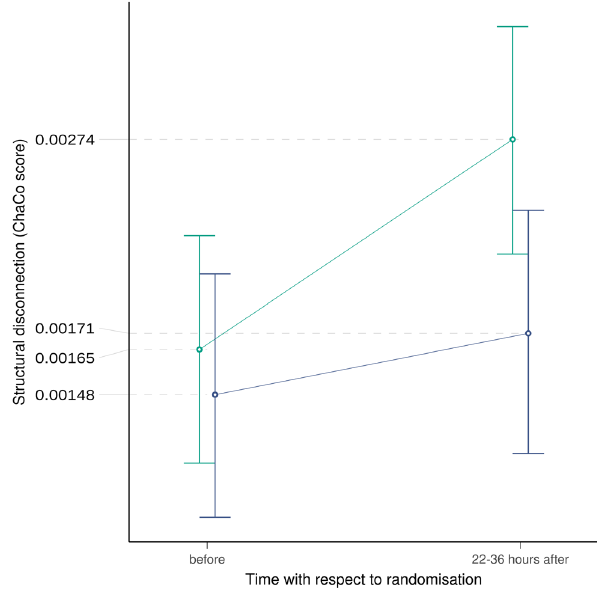
Fig. 3 Progression of average structural disconnection after stroke from before (T1) through 22 – 36h after (T2) randomization ( n = 269 biologically independent subjects examined at two time points), strati fi ed by allocation to placebo (persian green) or alteplase (tory blue). Circles represent structural disconnection quanti fi ed by mean average logarithmic Change of Connectivity (ChaCo) scores for the two groups. Vertical bars indicate 95% con fi dence intervals. The increase in structural disconnection, i.e. progressive loss of connectivity, is statistically signi fi cantly higher in the placebo group ( P = 7.40 × 10 − 4 after adjustment for lesion volume and spatial heterogeneity, see also Table 1 for corresponding